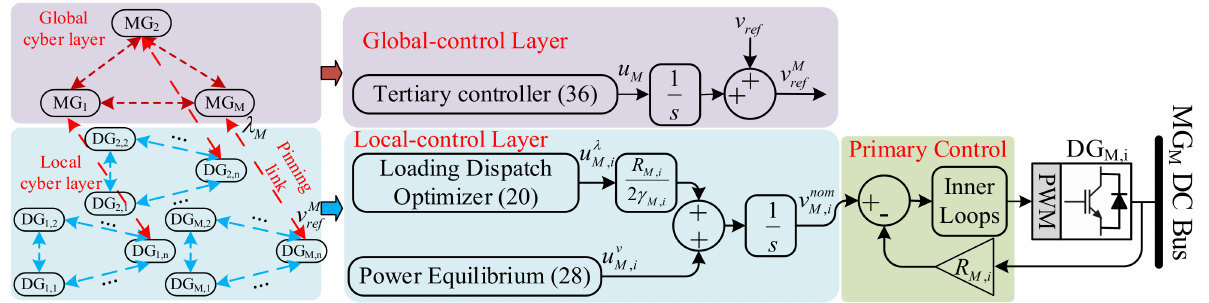
Figure 2. The developed dual-layer finite-time control